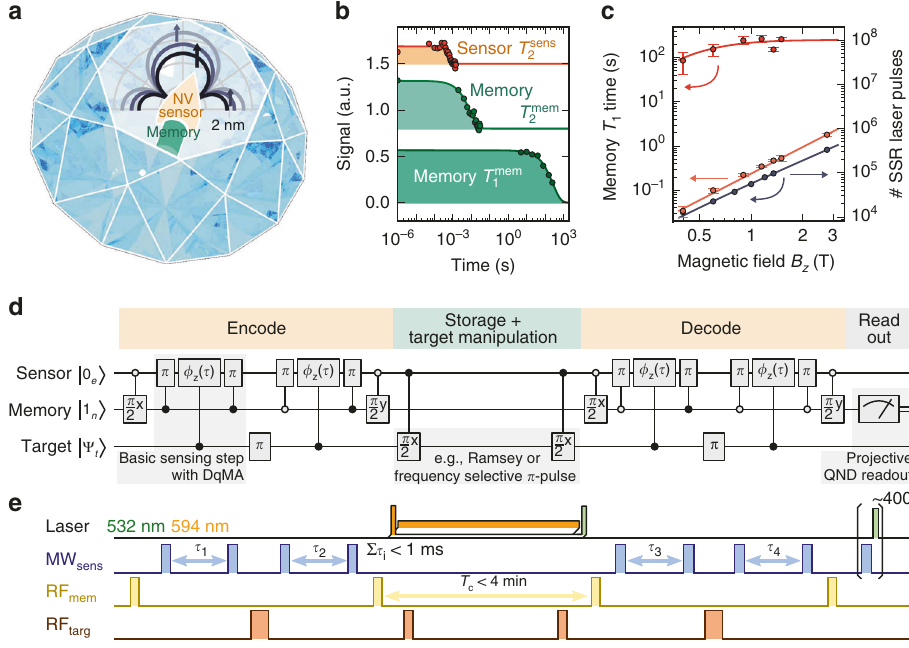
Fig. 1 The combined sensor – memory spin system. a Schematic representation of the sensor – memory pair comprising the electron and 14 N nuclear spin of an NV center in diamond. The inset sketches potential locations of 13 C target spins detected in this work. b Longitudinal and transverse relaxation times ( T 1 , T T mem -scaling with magnetic fi eld strength for three cases: NV center in the negative (red line), the neutral 2 ) of sensor and memory spin (sens, mem). c 1 charge state (orange line), and during continuous memory readout (gray line). The shown errors correspond to the standard error of the exponential fi t to the decay of the spin state. d , e Wire diagram and pulse sequence representation of an exemplary Ramsey measurement of target spins, sub-divided into four tasks: encoding; storage, and manipulation; decoding and readout. During encoding and decoding, the sensor phase ϕ (dependent on target spin state and duration τ i ) is transferred onto a memory superposition state. This process is ef fi ciently performed by entangling and disentangling sensor and memory with C m ROT s -gates granting the sensor direct quantum memory access (DqMA). Proper conditions of the C m ROT s -gates (i.e., open (closed) circle → sensor π - fl ip for memory state “ 0 ” ( “ 1 ” )) enable sensitivity to target spins and protection against quasi-static magnetic fi eld noise (see “ Methods ” ). Memory spin π /2 pulses (phases given by subscripts x and y ) switch between quantum (i.e., 0 j i þ e i ϕ 1 j i ) and classical (i.e., I z h i = sin ϕ ) information storage. Between subsequent basic sensing steps, target spins are fl ipped, during central storage, this is achieved with high spectral resolution via Ramsey interferometry (i.e., two RF π /2 pulses). Appropriate Laser illumination enables continuous sensor repolarization into 0 j i , or ionization into the neutral NV 0 for decoupling of sensor and target spins during central storage. During decoding, the current target spin state is correlated with its encoded initial state stored as expectation value I z h i on the memory. Finally, the memory state is readout in a single shot